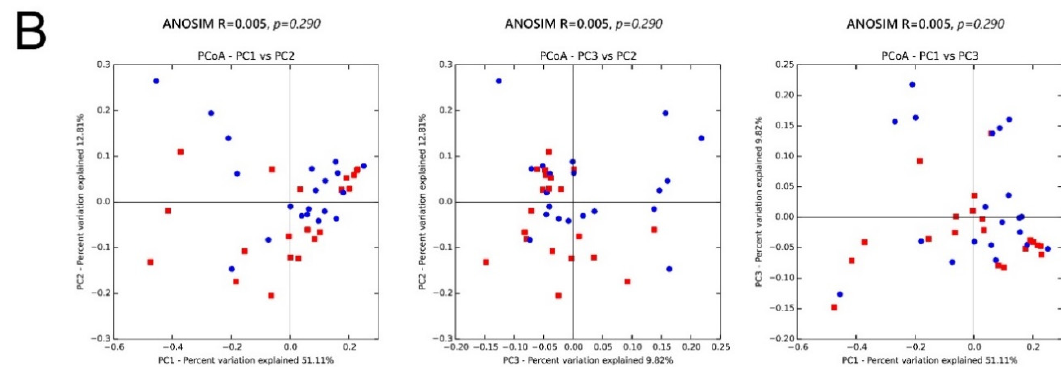
Figure 10. Microbiota β diversity (between-sample microbial diversity) based on principal coordinate analysis (PCoA) of weighted UniFrac distances. Two-dimensional PCoA plots display inter-sample distances by three principal coordinates (PC1, PC2, and PC3) with labeling of individual samples by ( A ) patient and ( B ) treatment, for patients 1 to 20. Principal coordinates, calculated from a distance matrix of weighted Unifrac distances, have no units.